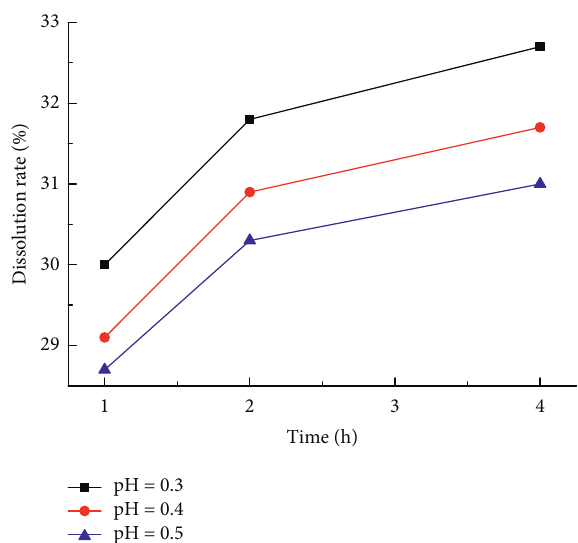
Figure 5: Dissolution rate of HF to sodium bentonite under different pH conditions.